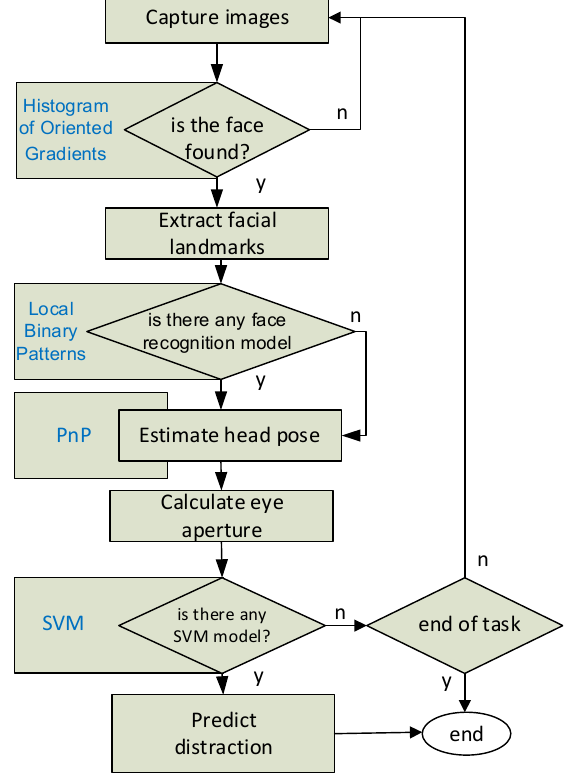
Figure 11. Flowchart of main module of SECS.